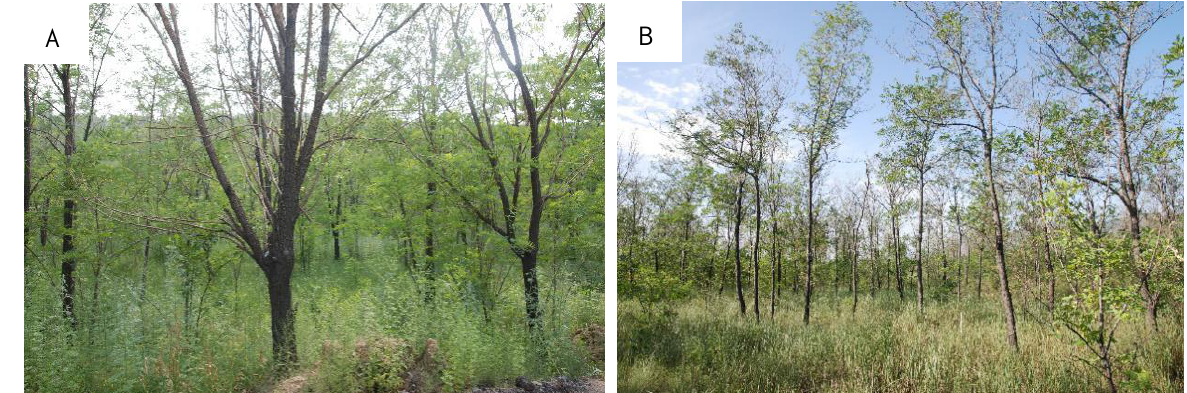
Figure 2. The landscapes of two sampling plots. ( A ): S I; ( B ): S II.